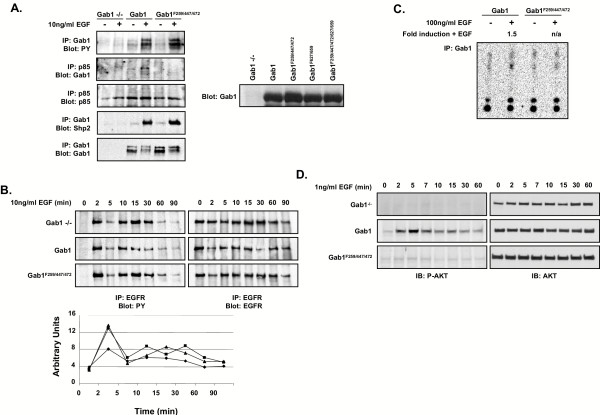
Expression of a Gab1 mutant protein deficient in p85 binding fails to rescue EGF-induced PI-3 kinase/Akt activation in Gab1 deficient MEFs. A. The indicated cell lines were serum-starved for 24 hours and stimulated with 10 ng/ml EGF for five minutes at 37°C. Cell extracts were prepared and analyzed for Gab1 tyrosine phosphorylation, Gab1 co-immunoprecipitation with p85, p85 expression, Gab1 co-immunoprecipitation with Shp2, and Gab1 expression. Both Gab1 and Gab1F446/472/589 are tyrosine phosphorylated in response to EGF treatment, and both form a stable complex with Shp2. However, Gab1F446/472/589 fails to associate with the p85 subunit of PI-3 kinase. Additionally total cell lysates from the indicated cell lines were immunoblotted with anti-Gab1 antibodies, providing independent evidence that Gab1 is expressed at approximately equal levels in all cell lines. B. The indicated cell lines were serum-starved for 24 hours and stimulated with 10 ng/ml EGF for varying periods of time at 37°C. Cell extracts were prepared and analyzed for EGFR tyrosine phosphorylation. All of the cell lines examined show similar kinetics of EGF-induced EGFR activation. Immunoblots were quantitated by densitometry, normalized for EGFR expression and represented linearly. Diamonds = Gab1 -/-, squares = Gab1, triangles = Gab1F446/472/589. C. The indicated cell lines were serum-starved for 24 hours and stimulated with 100 ng/ml EGF for five minutes at 37°C. Cell extracts were prepared and Gab1 immunoprecipitates were analyzed for PI-3 kinase activity. Ectopic expression of wild type Gab1 restored EGF-induced PI-3 kinase activity, while expression of Gab1F446/472/589 fails to rescue PI-3 kinase activity in response to EGF treatment. D. The indicated cell lines were serum-starved for 24 hours and stimulated with 1 ng/ml EGF for varying periods of time at 37°C. Cell extracts were prepared and analyzed for activation of Akt by using antibodies that specifically recognize the serine473-phosphorylated form of Akt. Membranes were subsequently stripped and immunoblotted for Akt to confirm equal loading. Ectopic expression of Gab1 in Gab1 -/- MEFs rescues activation of Akt in response to EGF treatment, while expression of Gab1F446/472/589 fails to rescue the EGF-induced Akt activation.